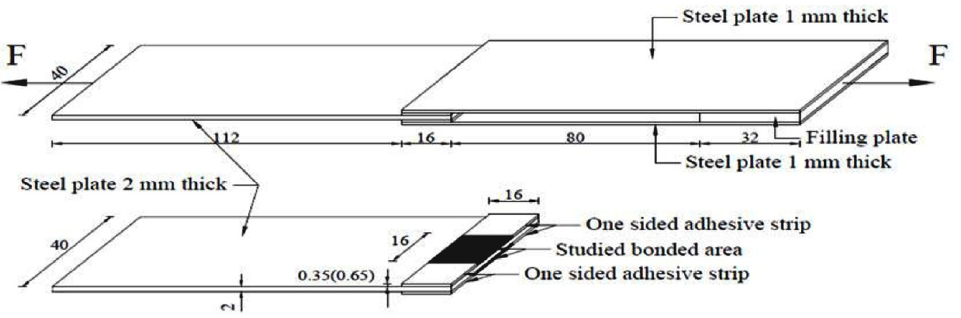
Fig. 1. Double lap shear joints black areas represent bonded